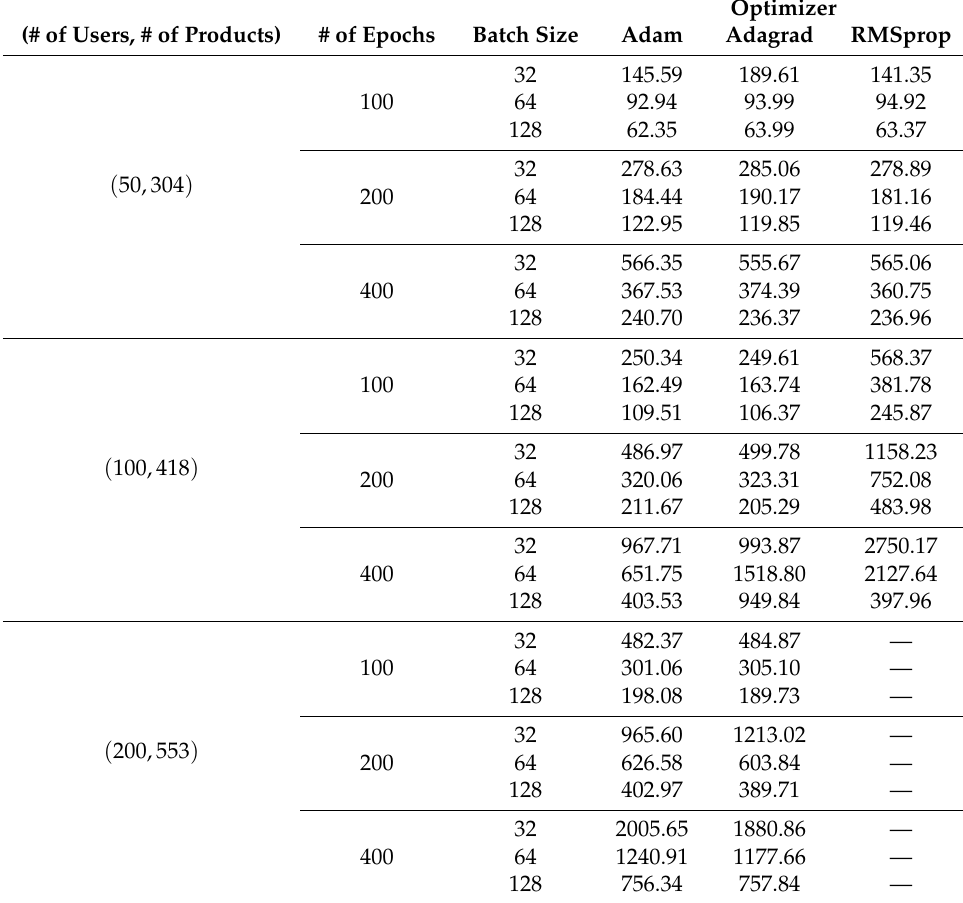
Table 4. Training times for the NCFO architectures